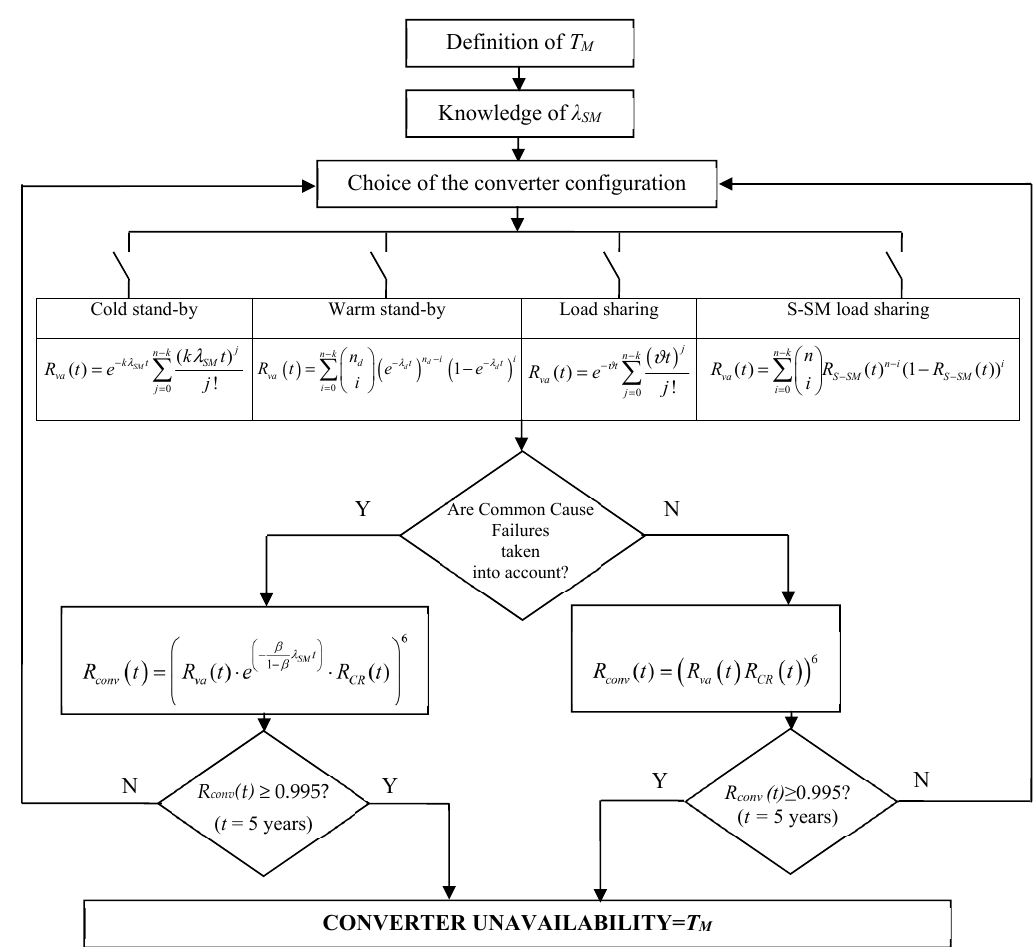
Figure 10. Procedure to determine the conversion system availability on the basis of the chosen redundant configuration.